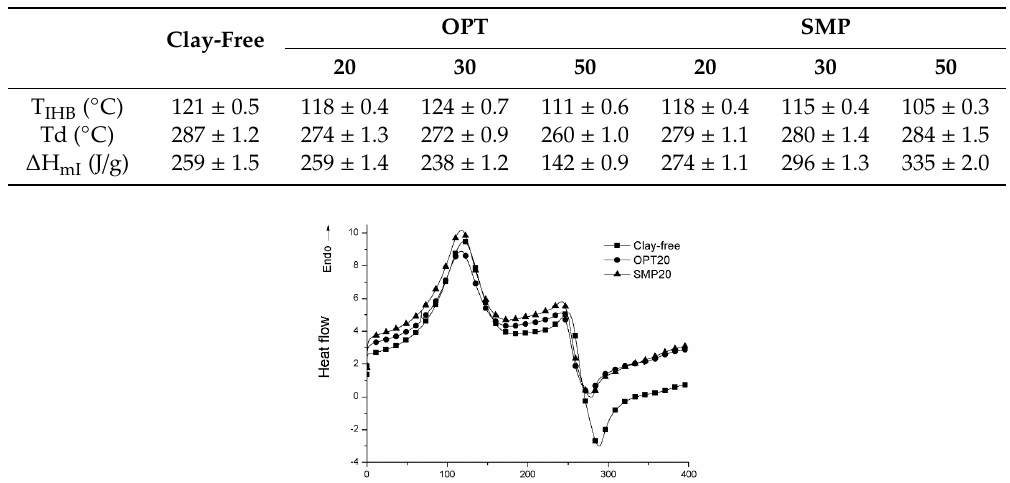
Table 2. Thermal properties of the chitosan and nanoclay-based supports. Clay-Free